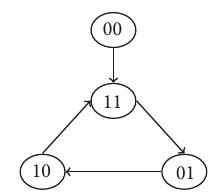
Figure 1: Phase diagram of the